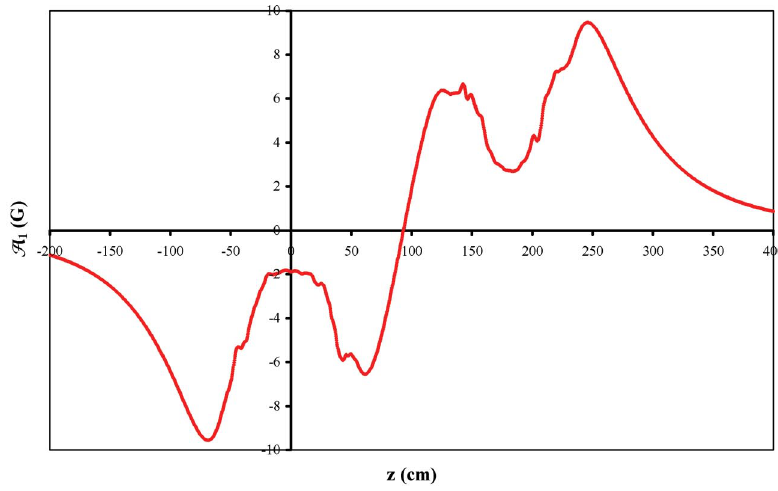
FIG. 6. (Color) Component A